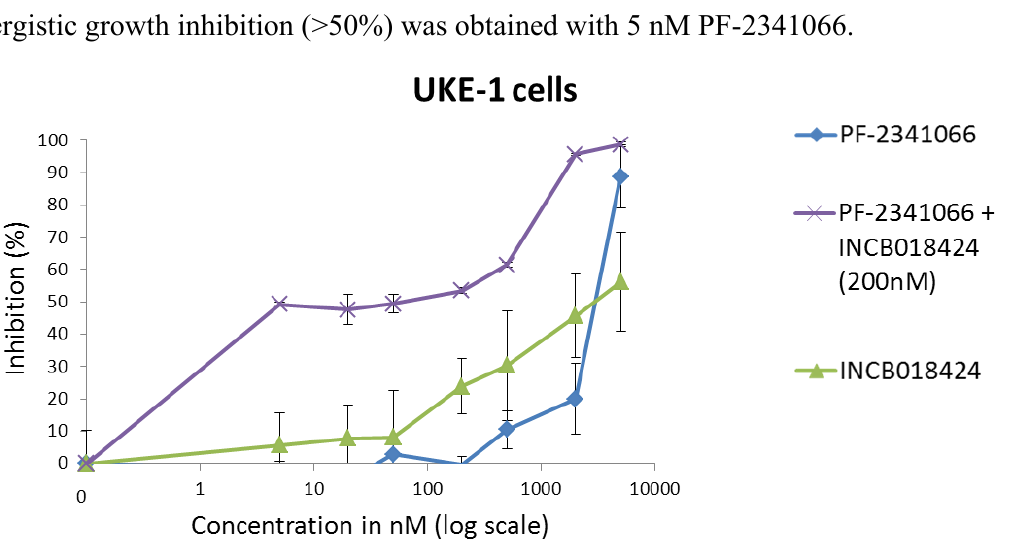
Figure 6. Synergy of MET and JAK inhibitors in JAK2 V617F-mutated cells. MET/ALK inhibitor PF-2341066 was tested alone and associated with anti-JAK1/2 inhibitor INCB018424 on the JAK2 V617F +/+ UKE-1 cell line. Only a weak inhibition was observed (at >1  M) when molecules were tested separately. When UKE-1 cells were treated simultaneously with INCB018424 (200 nM) and PF-2341066 (increasing